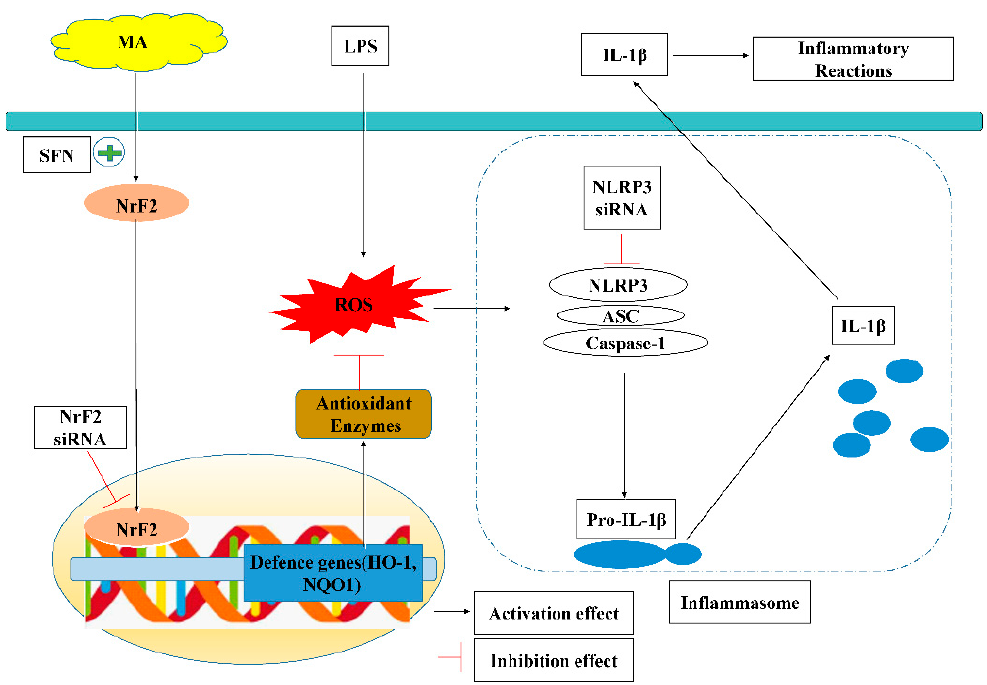
Figure 6. Proposed molecular mechanisms underlying the inhibitory effect of MA on the activation of macrophage induced by LPS. MA activates Nrf2 pathway to increase antioxidant genes and proteins, which in turn reduce inflammation and oxidative stress. The dashed lines are speculations based on previous research.